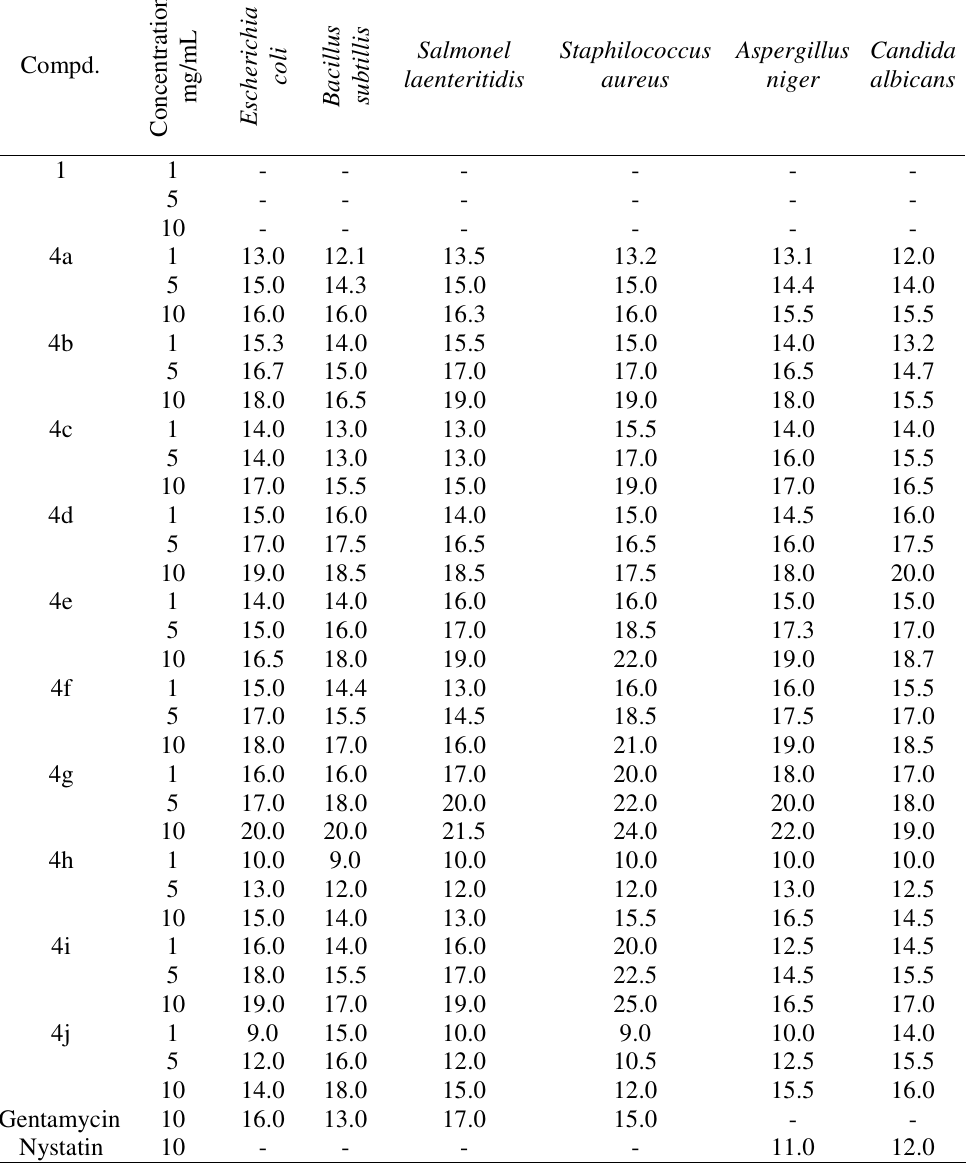
Table 1. Antimicrobial activity of 1, 4a-j -inhibition zones (mm) - no activity